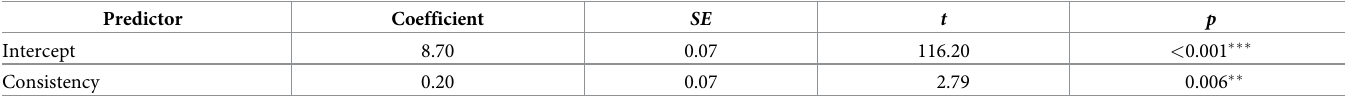
Table 4. Summary of the fixed effects in the mixed effect linear regression model incorporating only test consistency for Experiment